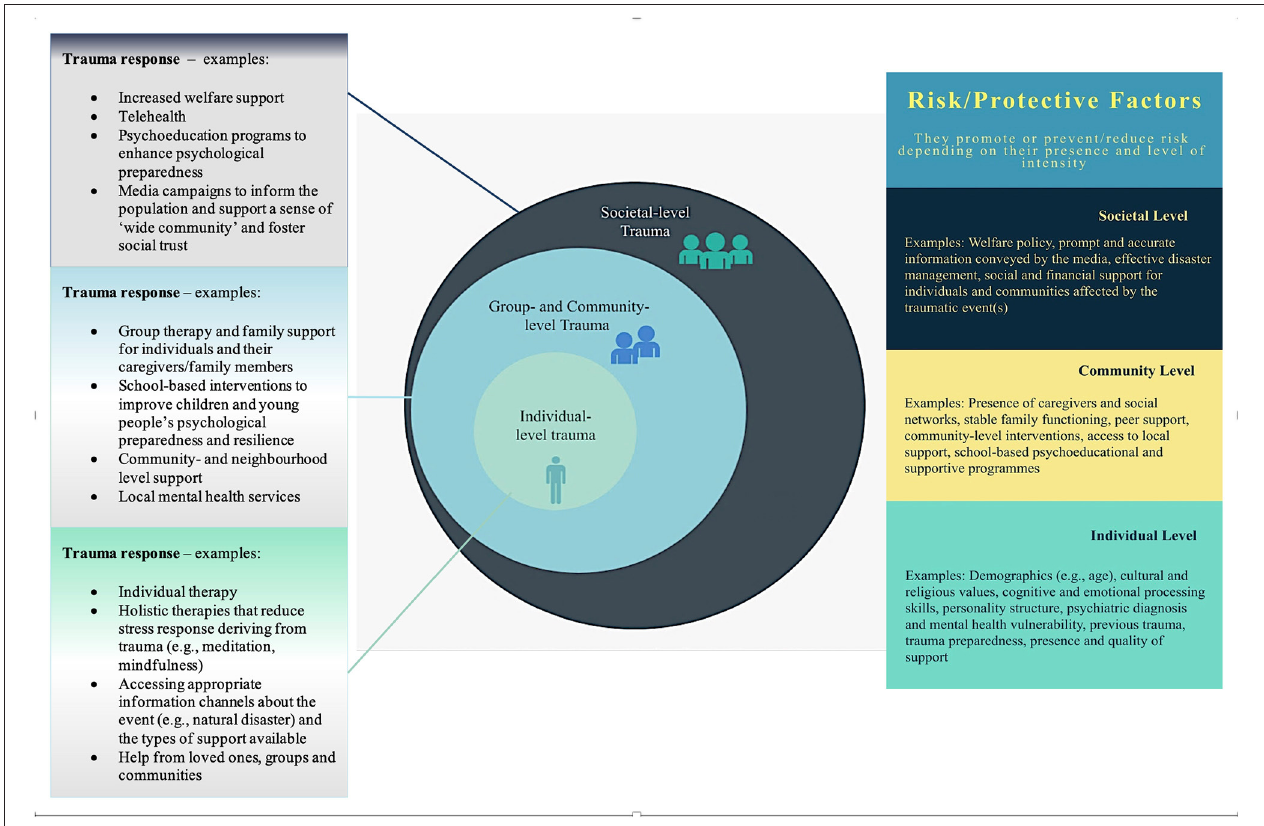
FIGURE 1 | Ecological Response to Complex Trauma (ERCT)